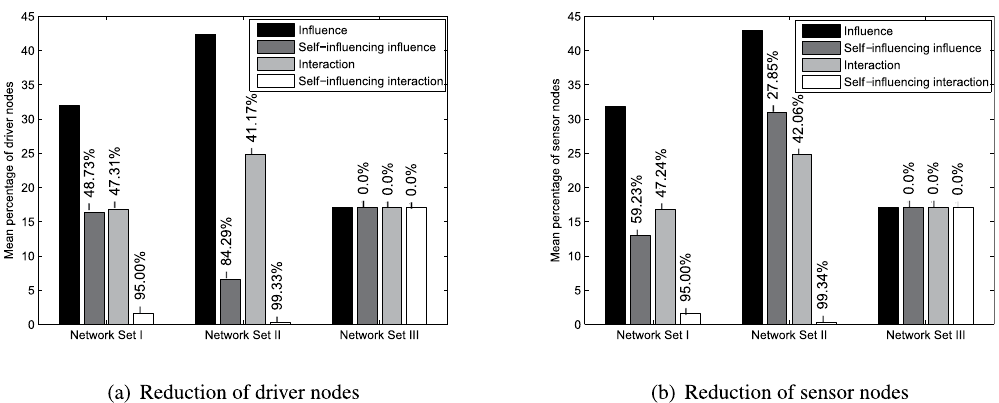
Figure 9. Proportion of driver and sensor nodes in networks with different connection types. Bar diagrams containing the mean of the proportion of driver ( a ) or sensor ( b ) nodes grouped according to network types. Apart from influence the numbers on the top of the bars show the reduction of driver and sensor nodes compared to the